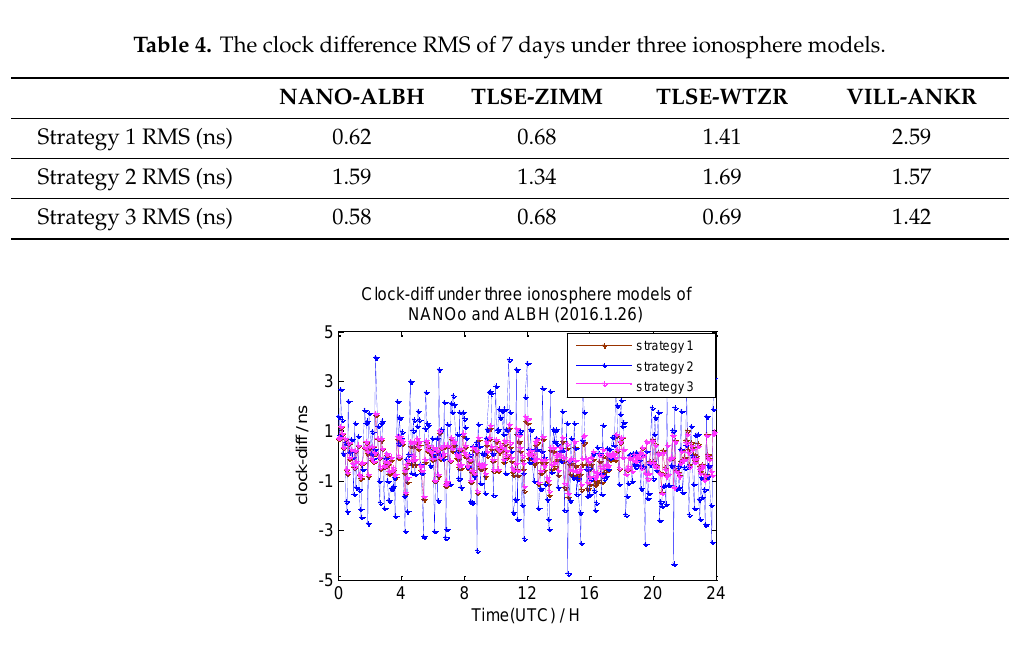
Figure 13. The clock di ff erence under three ionosphere methods of NANO and ALBH. Figure 13. The clock difference under three ionosphere methods of NANO and ALBH. Figure 13. The clock difference under three ionosphere methods of NANO and ALBH. Figure 13. The clock difference under three ionosphere methods of NANO and ALBH.